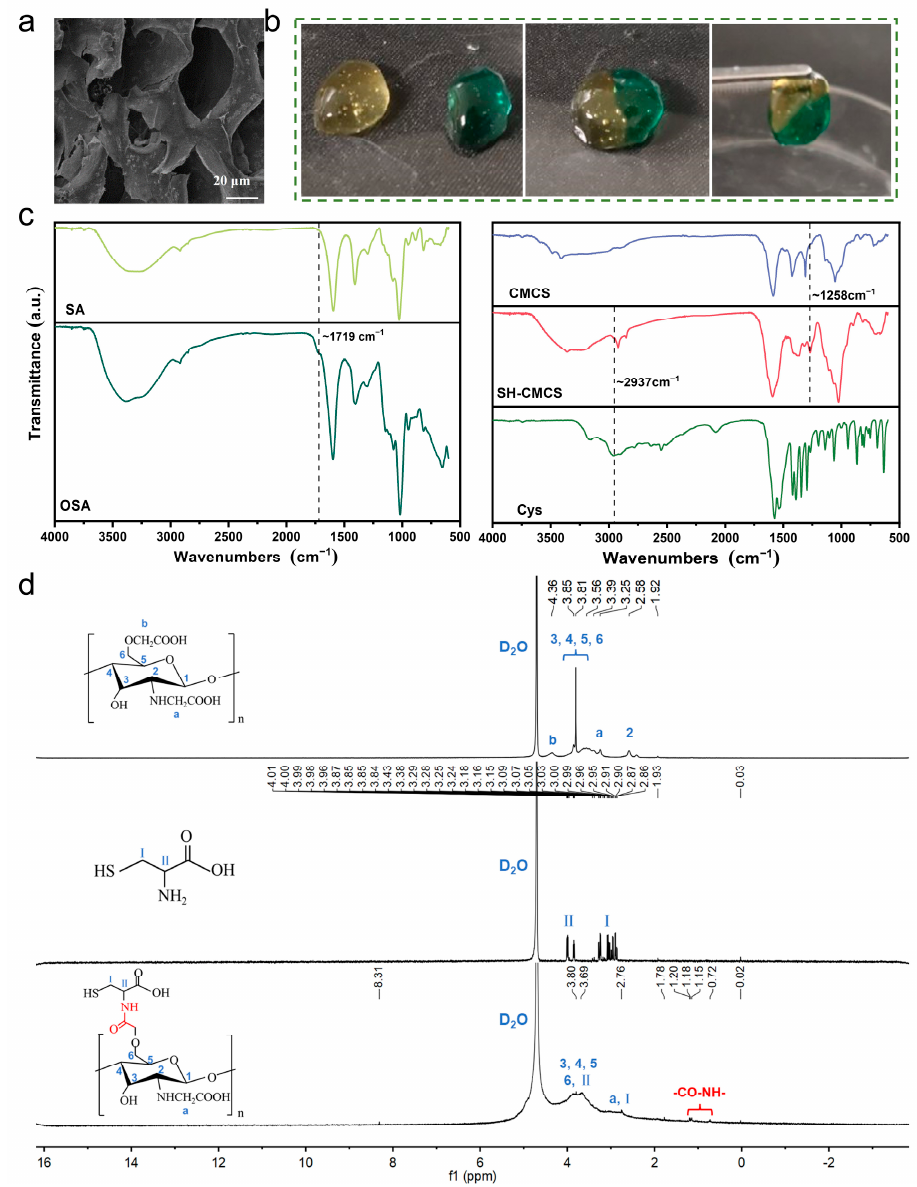
Figure 2. ( a ) Schematic diagram of self-healing hydrogel; ( b ) SEM diagram of SH-CMCS/OSA hydrogel; ( c ) FTIR of hydrogel; and ( d ) 1 H NMR of CMCS, Cys and SH-CMCS.